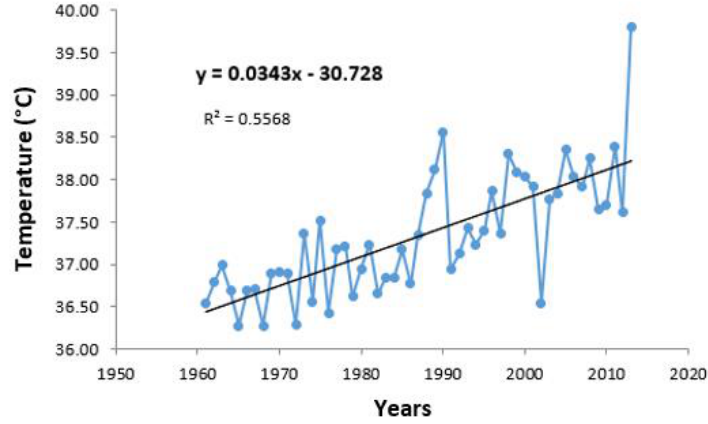
Figure 5. Annual averages of maximum temperature measured at the DIA station.